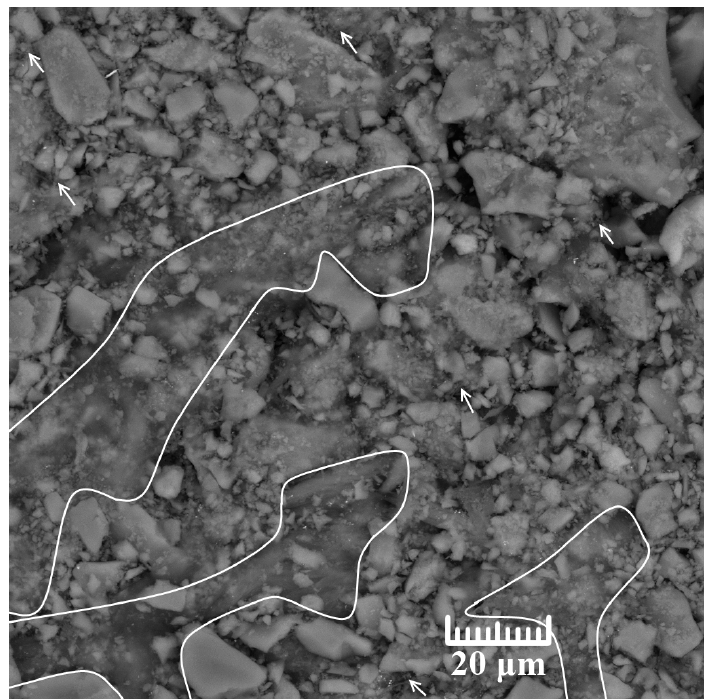
Figure 2. SEM image of the MgH 2 –5 wt.% SWCNT composite obtained after 60 min of ball milling at a speed of 300 rpm. Areas marked by white lines indicate areas with a high concentration of nanotube bundles; white arrows mark individual distributed nanotube bundles.